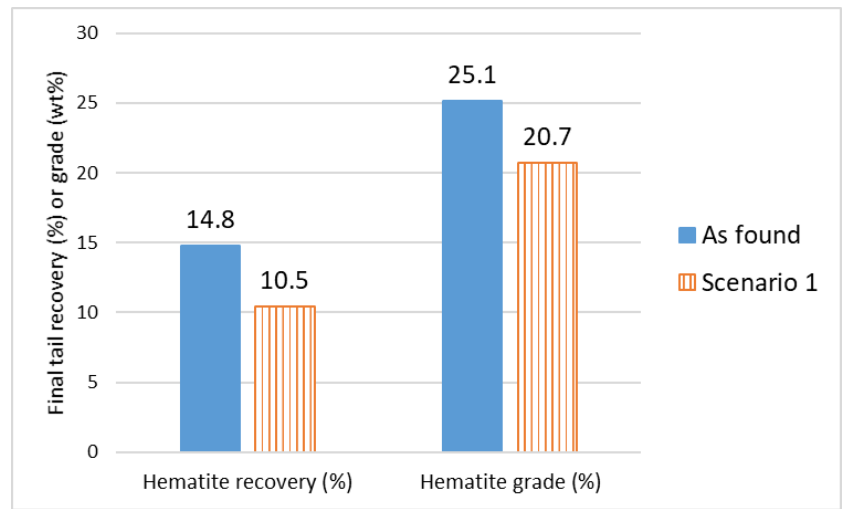
Figure 7. Final tail hematite recovery based on plant feed and grade for “as found” and scenario 1.